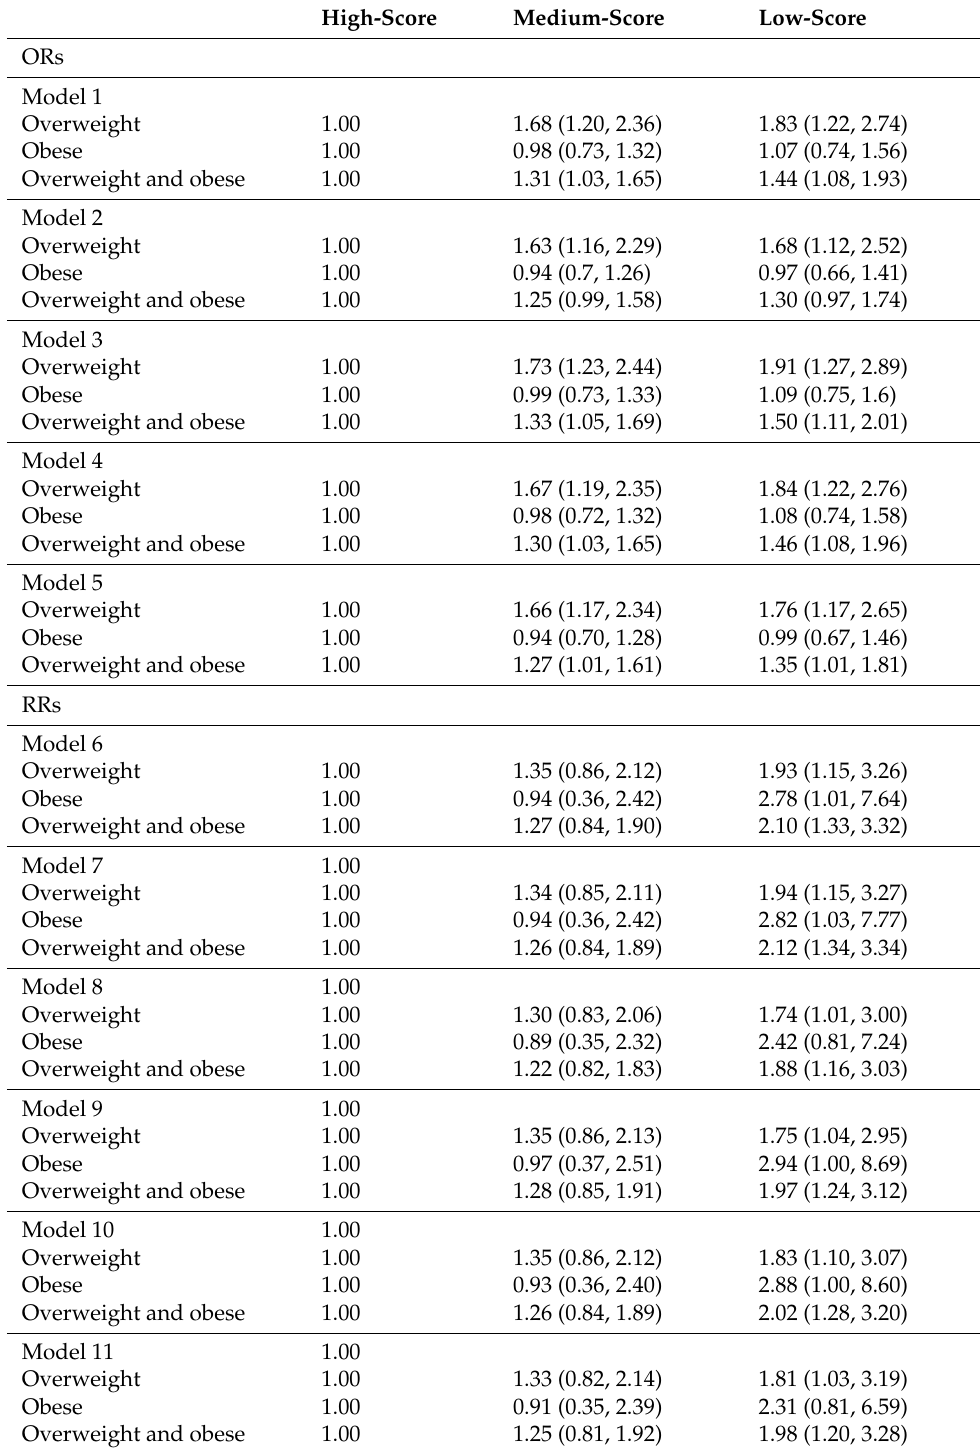
Table 4. ORs (baseline) and RRs (follow-up) of overweight and obese children (OR [95% CI]/RR [95%